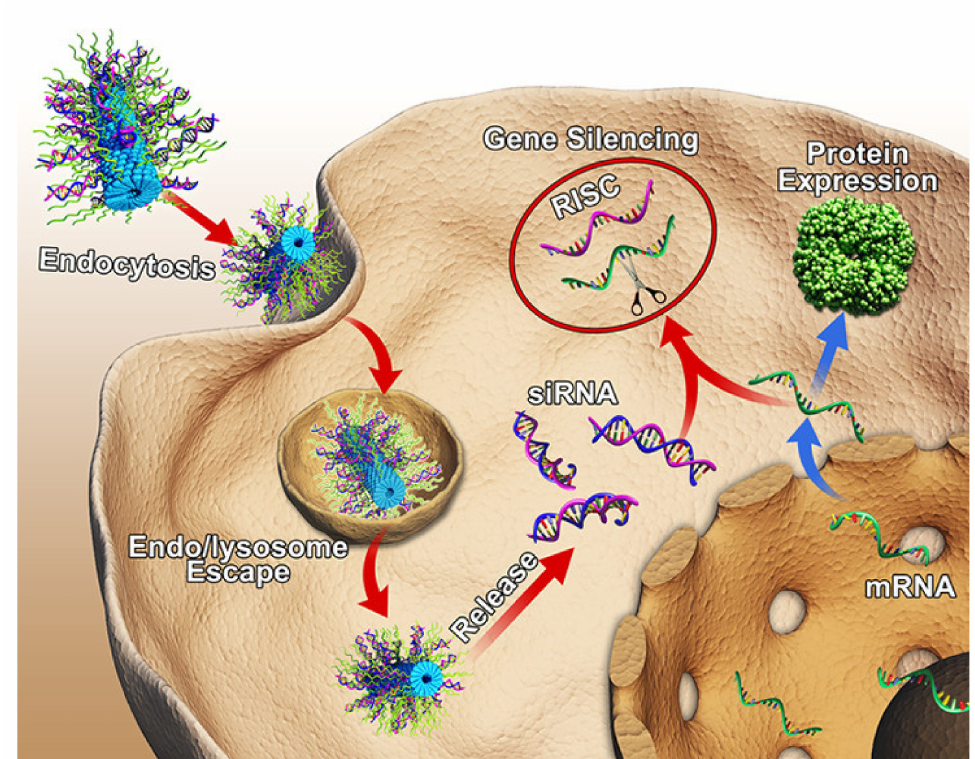
Figure 3. Schematic illustration of cell penetrating TAT peptides complexed with siRNA and inte- grated into modified tobacco mosaic virus (TMV) for virus-inspired gene silencing. Reprinted with permission from [52]. Copyright 2018 American Chemical Society.